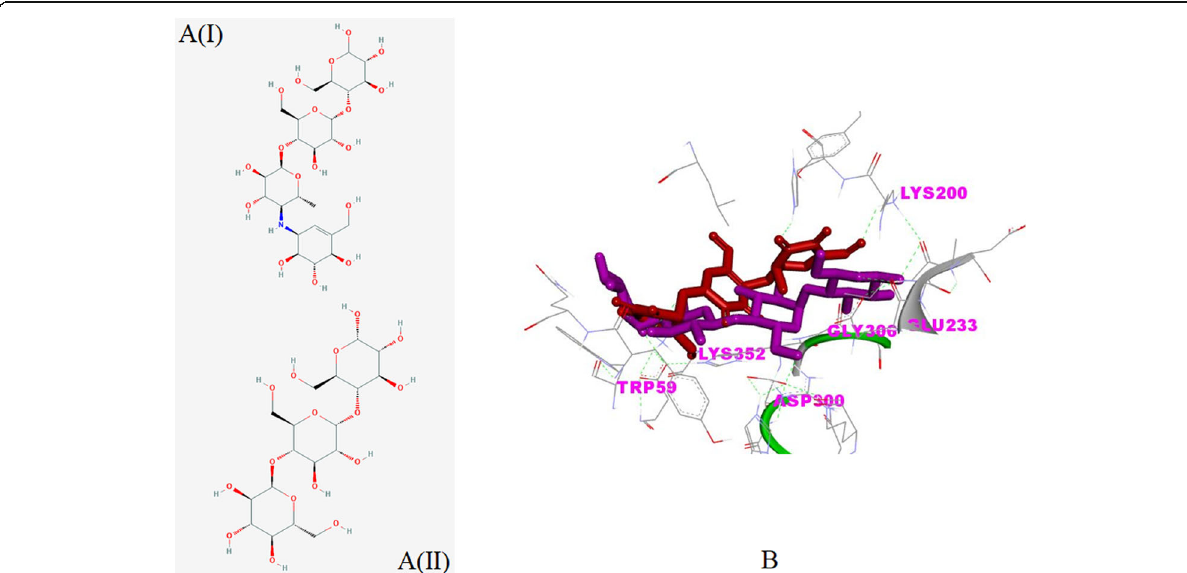
Fig. 4 Molecular docking simultaneous interaction pattern of amylose and acarbose with the active site of HSA (PDB ID: 1SMD) generated using AutoDock Tools 4.2 platform [ A(I) ] 2D structure of acarbose (PubChem CID: 41774) [ A (II) ] 2D structure of amylose (PubChem CID: 192826) ( B ) 3D docking representation of simultaneously docked compounds (amylose- substrate in red and acarbose- inhibitor in magenta) in the binding pocket showing the hydrogen bond interactions